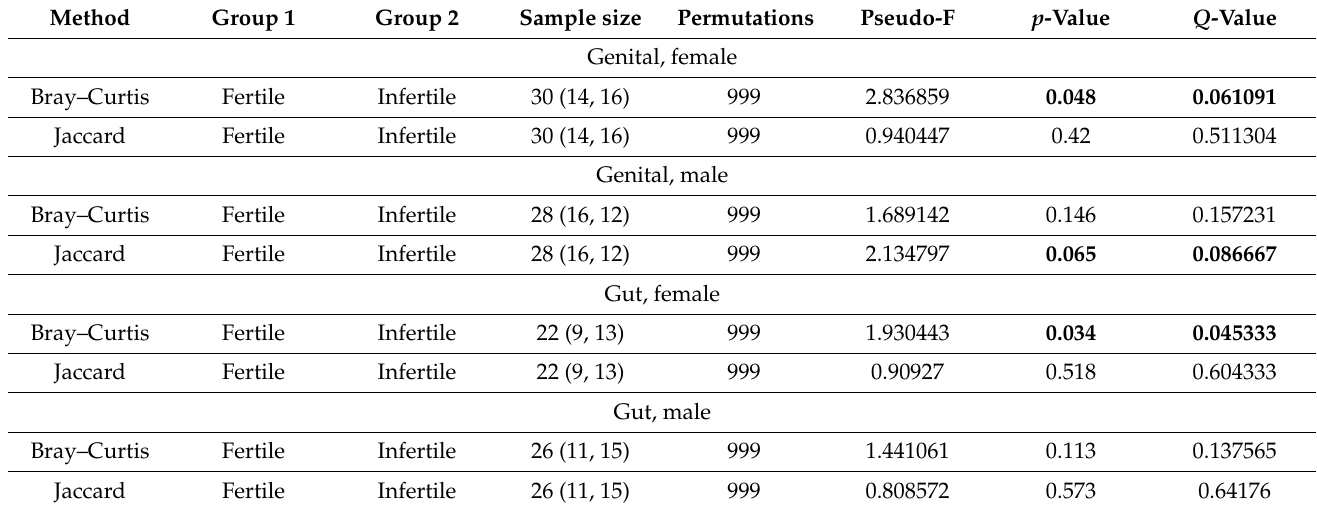
Table 9. Differences in the beta-diversity of KO metagenome between samples. (PERMANOVA, <0.1 are in bold).